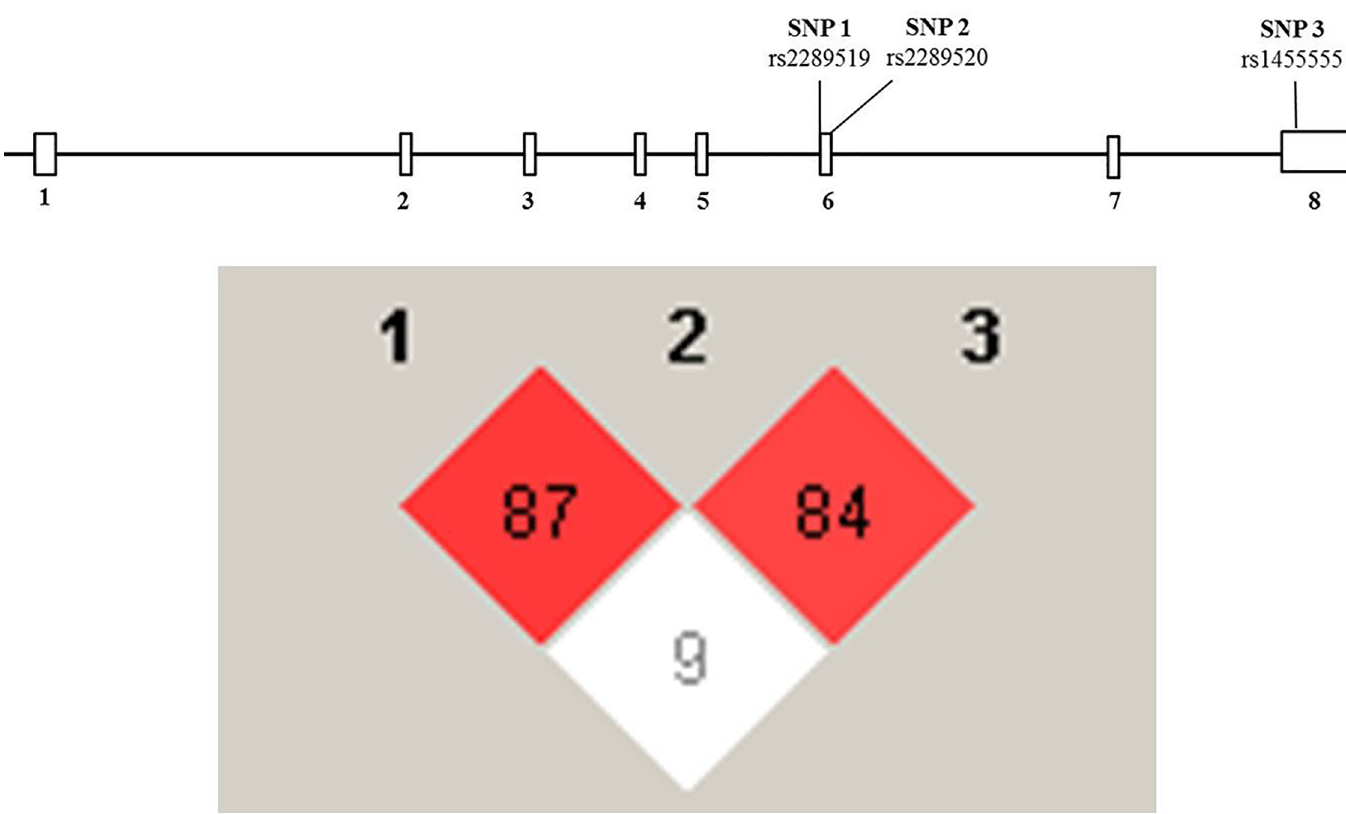
Fig 1. The location of human Maspin gene SNPs their pairwise linkage disequilibrium patterns. Schematic presentation of the Maspin, indicating the locations of the SNP polymorphism. The numbers in the squares represent the pairwise D ’ value.